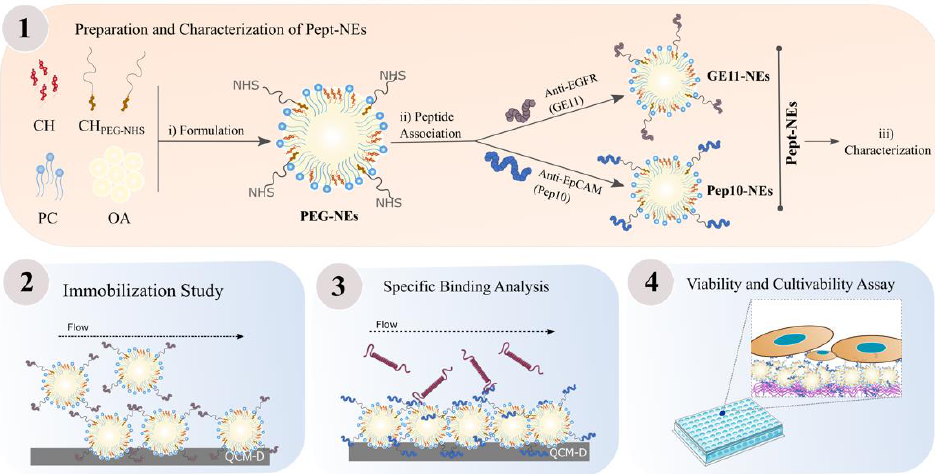
Figure 1. Workflow for the Development and Characterization of Peptide-functionalized Nanoemulsions (Pept-NEs). (1) Preparation and characterization of Pept-NEs: (i) formulation of PEG-NEs, (ii) association with two peptides (GE11 and Pep10) to obtain GE11-NEs and Pep10-NEs, and (iii) characterization. (2) Study of the immobilization of NEs on surfaces by Quartz Crystal Microbalance with Dissipation Monitoring (QCM-D). (3) Study of the specific binding ability of Pept-NEs to their targeted protein by QCM-D. (4) Cell viability and cultivability study for 9 days on Pept-NEs functionalized plates.